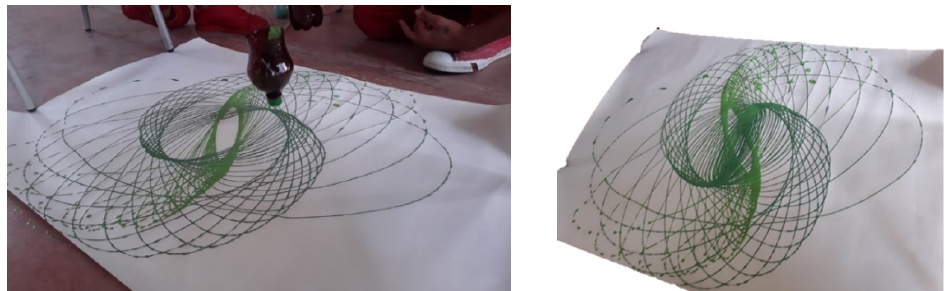
Figure 2. Simple pendulum as a way of doing art. The patterns formed by using an artifact turned into a pendulum. By varying the heights and axes of action on the pendulum, the paper’s patterns varied. Left : students testing different pendulum heights to observe the patterns formed. Right : pattern obtained through experimentation.